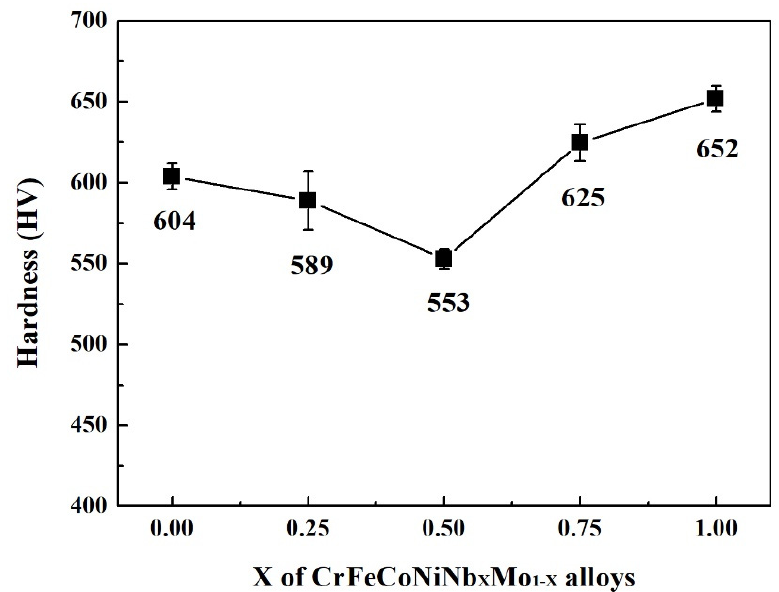
Figure 8. Hardness of as-cast CrFeCoNiNb x Mo 1 − x alloys. Each value is the average hardness of the alloy. Some of the data are from our previous study [23].